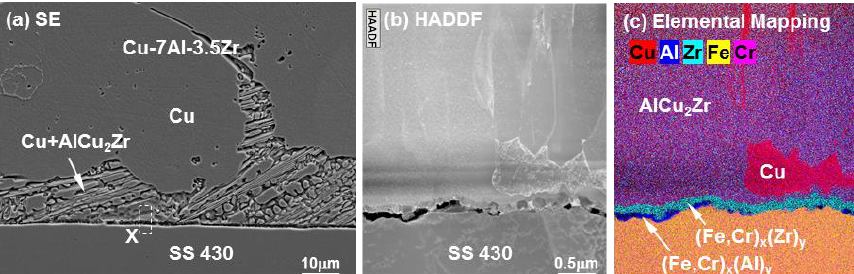
Figure 12. ( a ) Secondary electron (SE) image of the interface between Cu-7Al-3.5Zr and SS430 in a joint brazed at 1000 °C for 10 min. ( b ) high-angle annular dark-field (HAADF) image of area X in Figure 12a, and ( c ) the corresponding elemental spectral analysis for Cu, Al, Fe, Zr, and Cr. It shows a Zr-rich reaction layer and Al-rich sub-layer at the Cu-7Al-3.5Zr and SS430 interface.